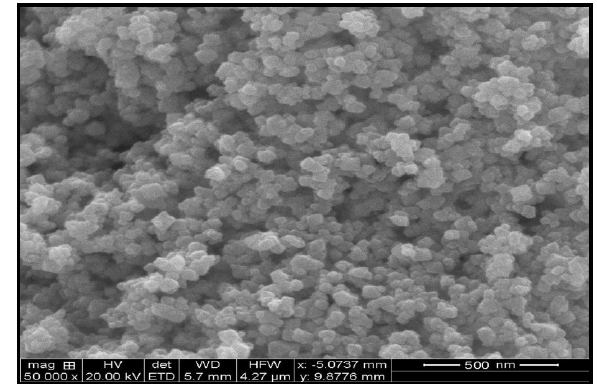
Figure 3. SEM micrograph of prepared magnetite